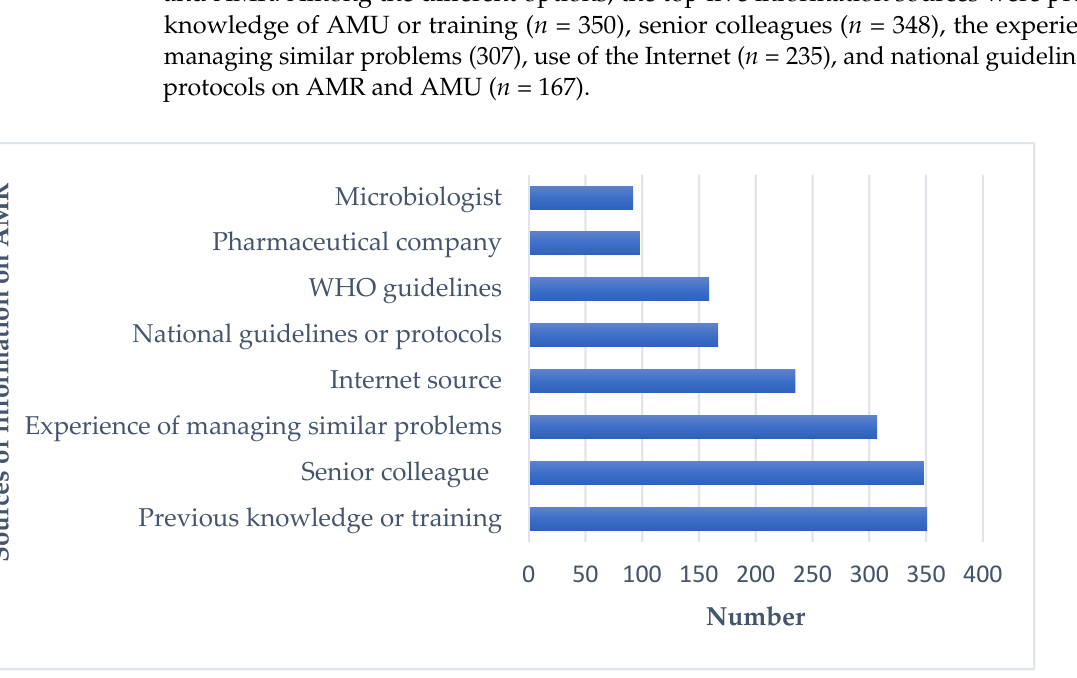
Figure 1. Sources of information on AMR for participants.